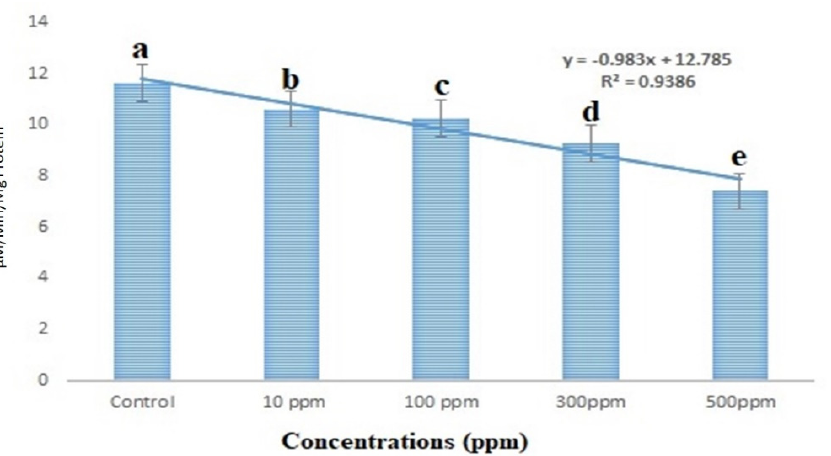
Figure 6. Acetylcholinesterase activity after the treatment with copper nanoparticles against 3rd instar larvae of S. frugiperda . According to the Tukey test at p ≤ 0.05, statistical values followed by the same letter do not differ significantly (one-way